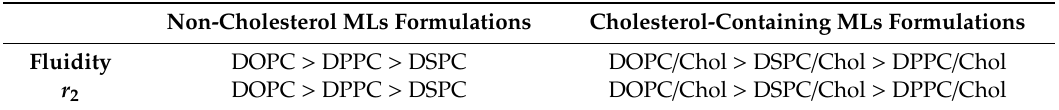
Table 5. Summary of results showing the influence of the phospholipid composition of MLs on the bilayer fluidity and the r 2 relaxivity